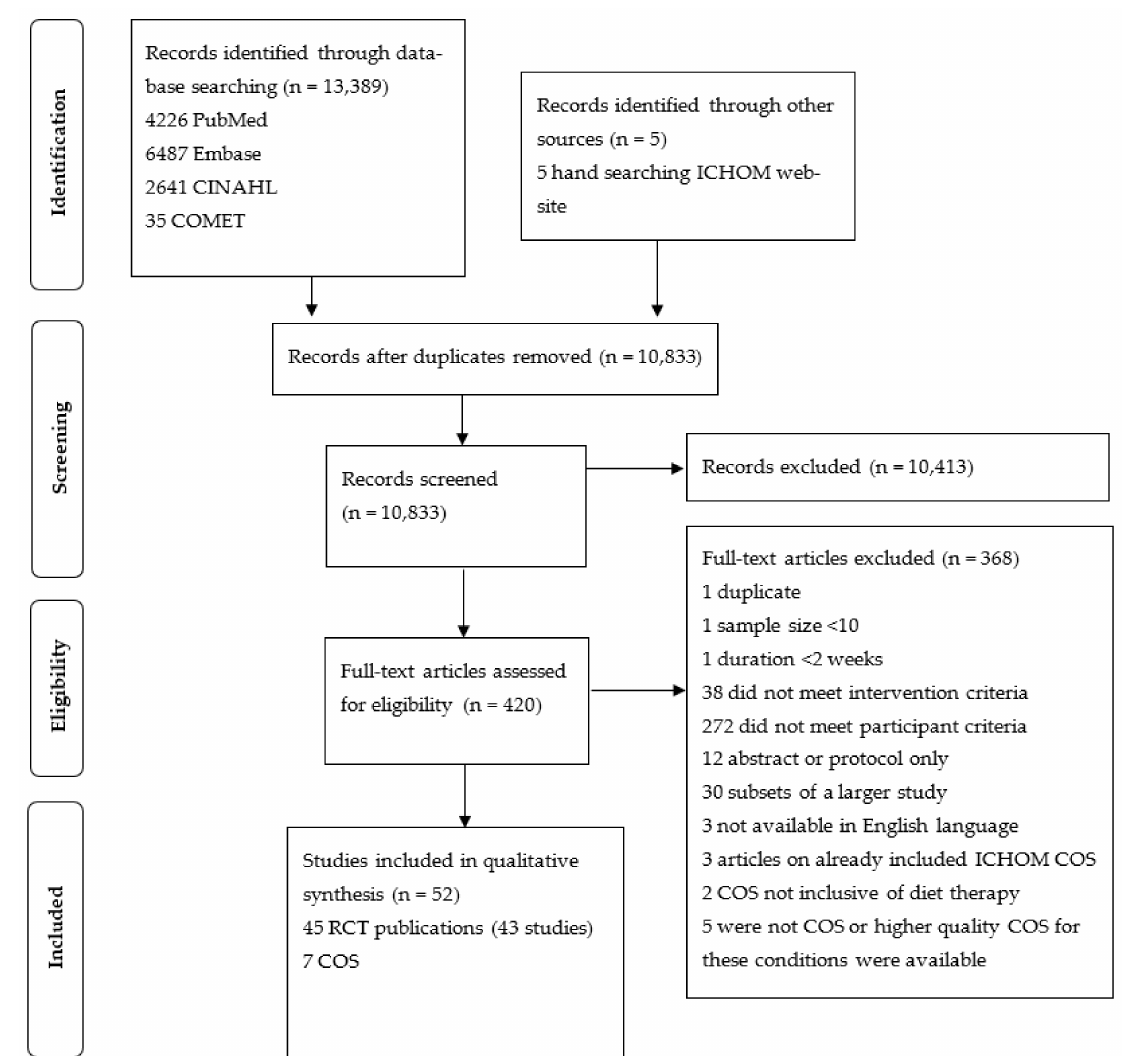
Figure 1. PRISMA flowchart illustrating the study selection